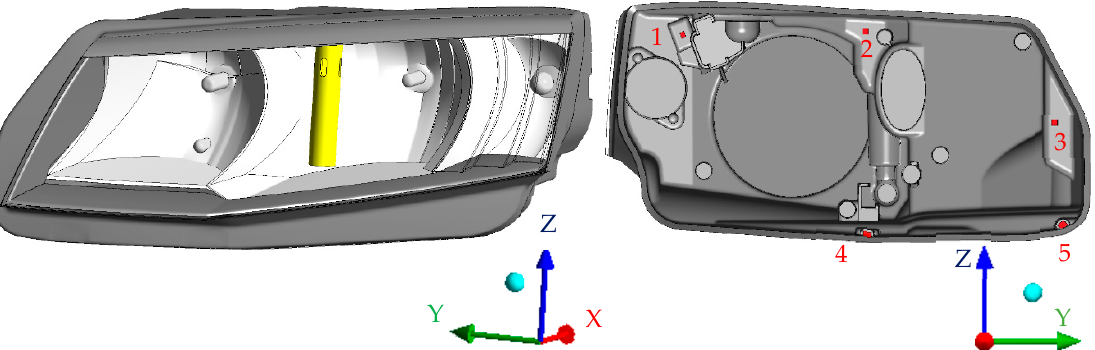
Figure 4. Geometric model used for the numerical simulations. ( left ) Position of the humidifier; ( right ) positions of the vent holes (1 − 4: inlets; 5: outlet).